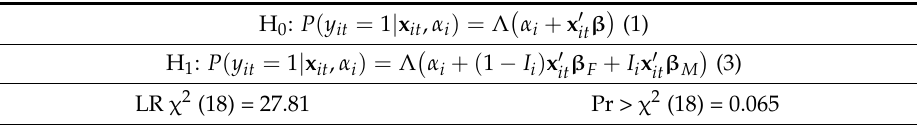
Table 4. Likelihood-Ratio Test (LR) Unrestricted and Restricted Models by